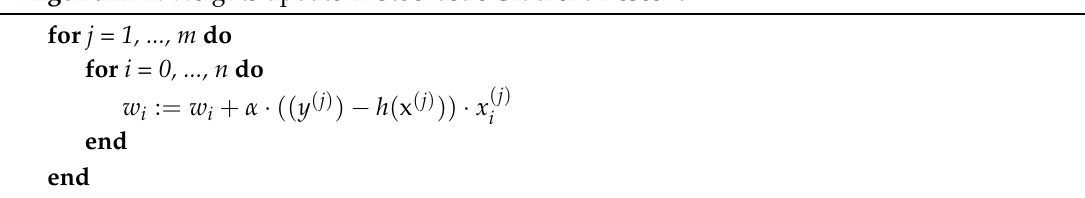
Algorithm 1: Weights update in Stochastic Gradient